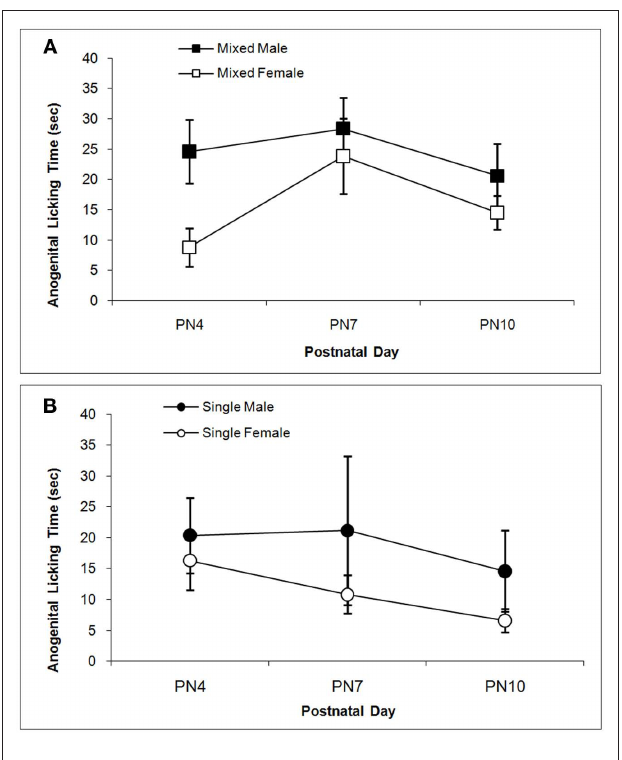
FiguRE 4 | Mean ( ± SEM) times the dam spent licking the body of her pup except in the anogenital region are presented for mixed- [squares; (A)] and single- [circles; (B)] sex litters for male (closed symbols) and female (open symbols) rats over postnatal days. Dams lick the body of male pups more than female pups. See text for